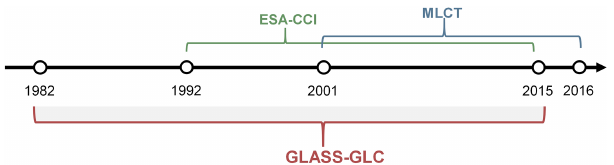
Figure 8. The duration of different land cover products, includ- ing the GLASS-GLC (annual dynamics of global land cover), MLCT (MODIS Land Cover Type), and ESA-CCI (European Space Agency Climate Change Initiative) land cover